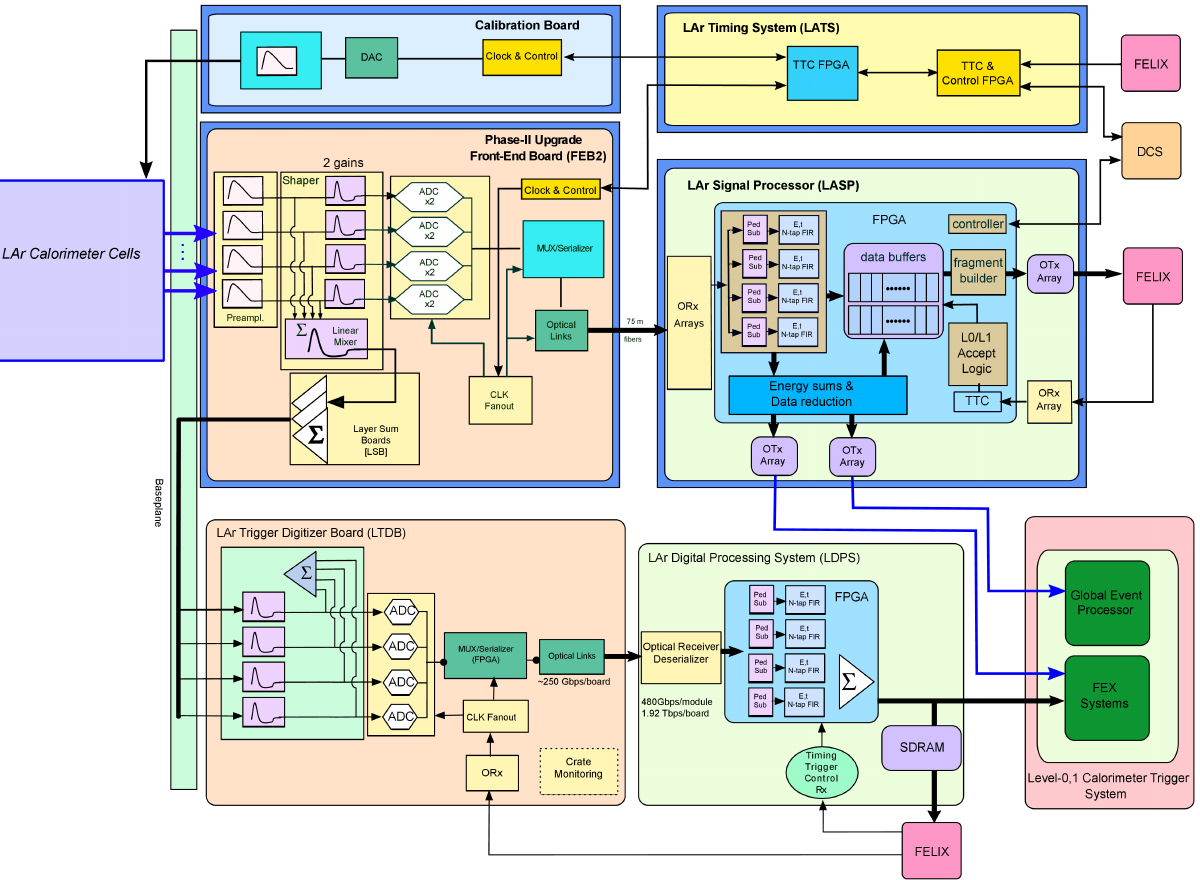
Figure 2. Block diagram of the LAr readout in the HL-LHC, including all on- and off-detector